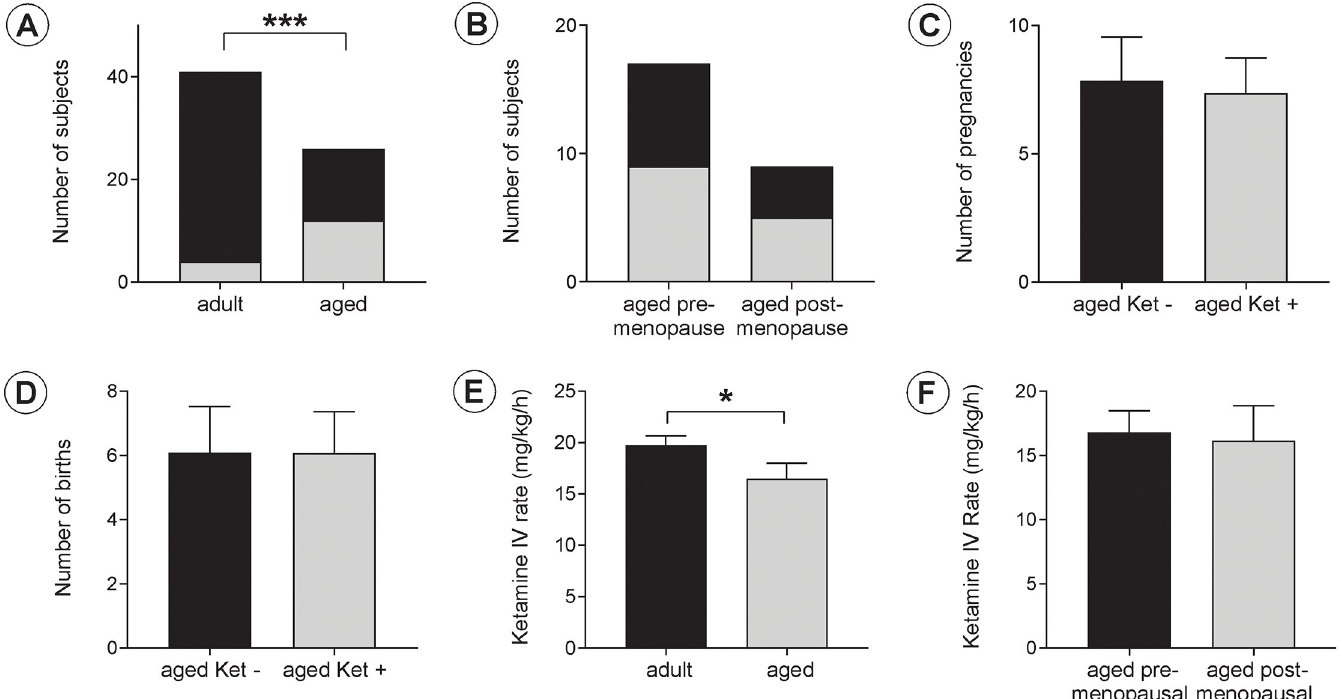
Fig 1. Effects of aging on ketamine-associated neuromuscular reactivity and in the infusion rate for a light plane of sedation. A. A total of 4/41 adult subjects (9.7%) and 14/26 aged subjects (53.8%) exhibited ketamine-associated neuromuscular reactivity and was significantly more prevalent in the aged subjects ( P < 0.001). B. Among the aged rhesus macaques, there was no difference in ketamine-associated neuromuscular reactivity between pre- and post-menopausal subjects. C, D. There was no difference in the number of pregnancies and live births for aged animals with and without ketamine-associated neuromuscular reactivity (Ket+ and Ket-, respectively. E. The ketamine IV infusion rate to achieve equal light planes of sedation was lower in the aged subjects (16.5 ± 1.5 mg/kg/h) compared to the adult animals (19.8 ± 0.9 mg/kg/h) ( P < 0.05). F. Among aged rhesus macaques, there was no difference in the ketamine infusion rate for equal light planes of sedation between pre- and post-menopausal subjects.